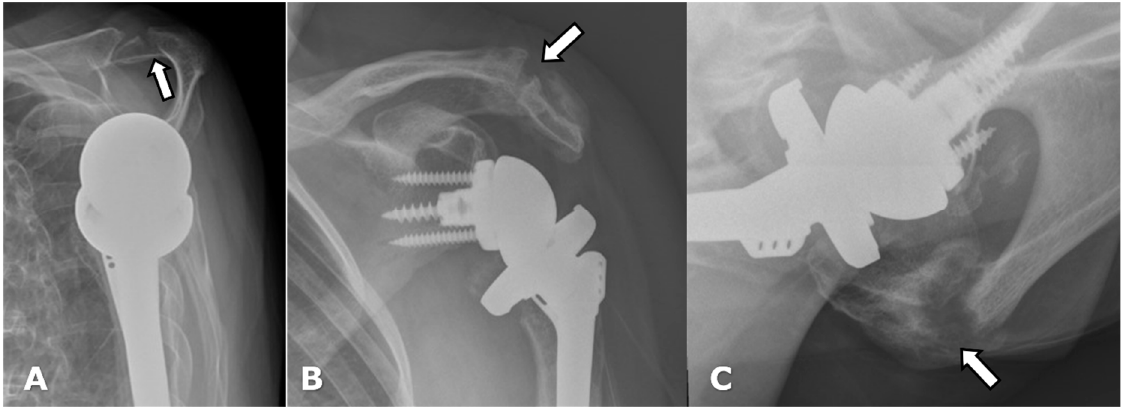
Figure 18. ( A ) Scapular Y radiograph in a patient with an RTSA shows an acute acromial fracture (arrow). ( B ) Frontal and ( C ) axillary radiographs in a di ff erent patient demostrate a healing acromial fracture (arrow) following RTSA.